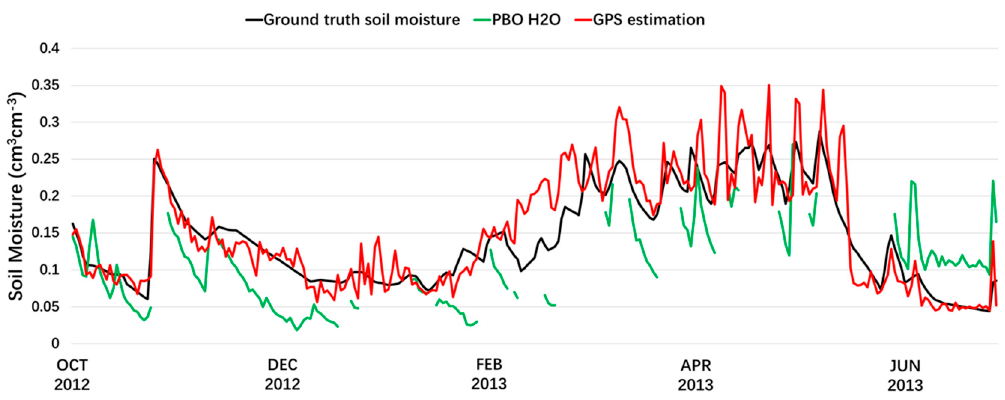
Figure 7. GPS estimation results of MFLE from 2012.10.01 to 2013.06.30.